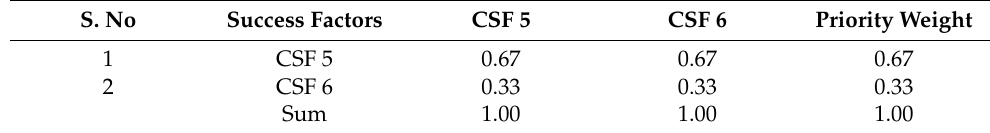
Table 21. Normalized matrix for integration level success